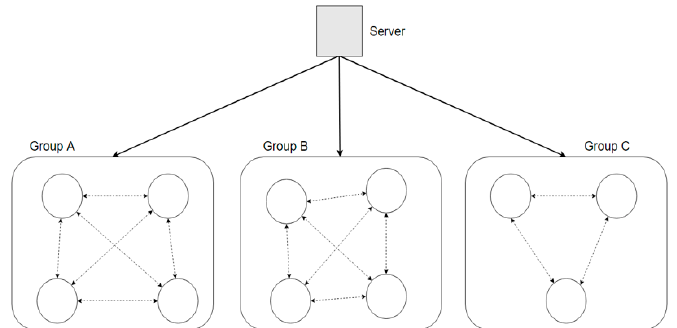
Figure 3. Grid computing method in a mesh overlay network structure.